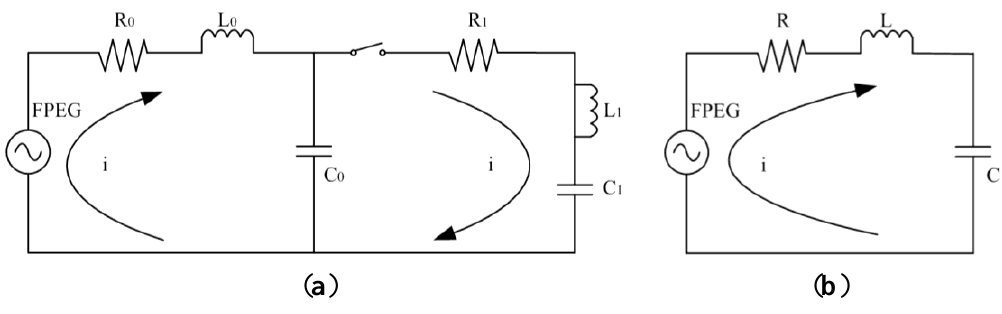
Figure 2. ( a ) FPELG equivalent circuit diagram; ( b ) Simplified FPELG equivalent circuit